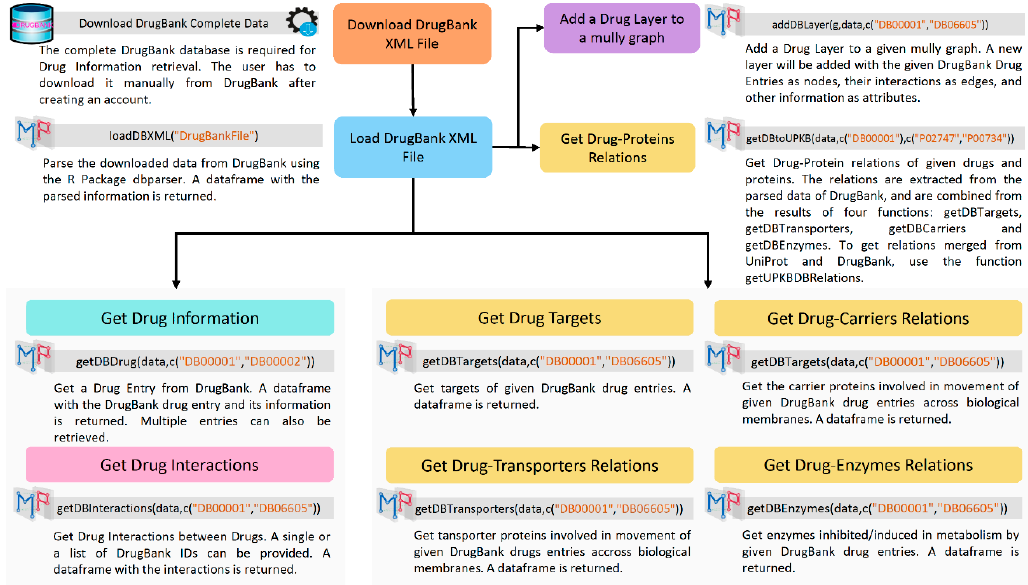
Figure 2. DrugBank Workflow Diagram. The Diagram shows the steps to get Drug Information from DrugBank using Multipath and the R Package DrugBank using Multipath and the R Package dbparser.